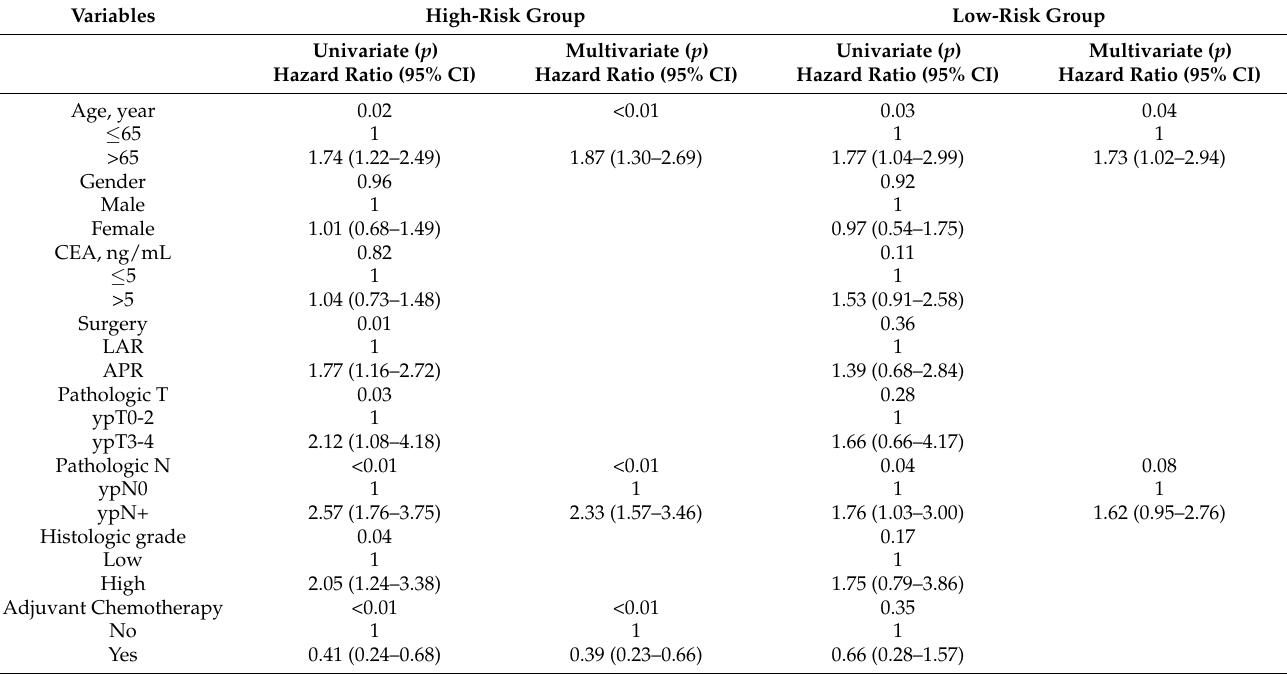
Figure 2. Survival curves in high-risk group. ( A ) Overall survival ( B ) Recurrence-free survival ( C ) Distant metastasis-free survival (HR, hazard ratio; CI, confidence interval). Multivariate analysis revealed that the adjuvant chemotherapy was significantly associated with OS [hazard ratio (HR), 0.39 and 95% of confidence interval (CI), 0.23–0.66; p < 0.01] after adjusting for gender, serum CEA, surgery, pathologic T stage, and histologic grade (Table 2). Table 2. Prognostic factors associated with overall survival in high-risk group and low-risk group.